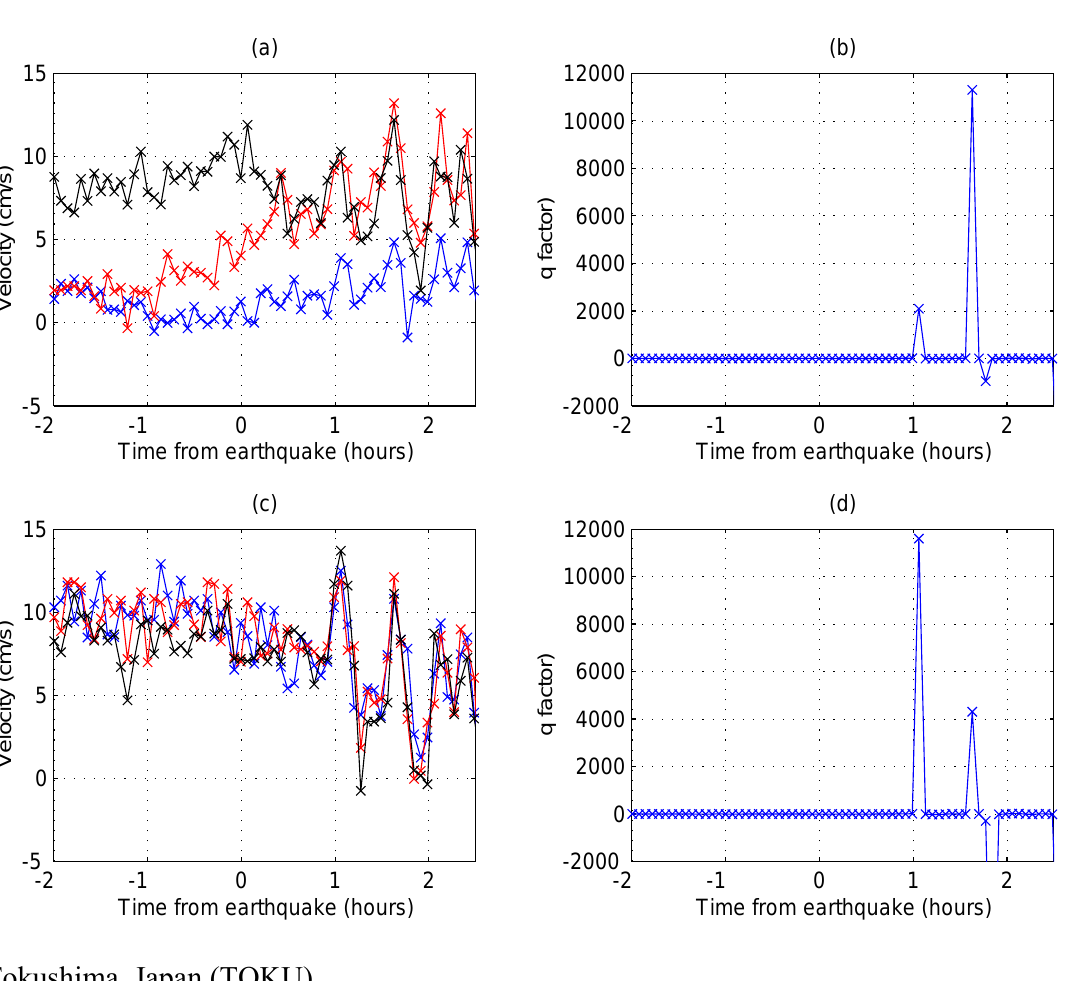
Figure 5. Time series of velocity components from radar A088. ( a ) Blue: 0–2 km; Red: 2–4 km; Black: 4–6 km over 5 h ( b ) q-factor for 0–6 km offshore ( c ) Blue: 6–8 km; Red: 8–10 km; Black: 10–12 km ( d ) q-factor for 6–12 km